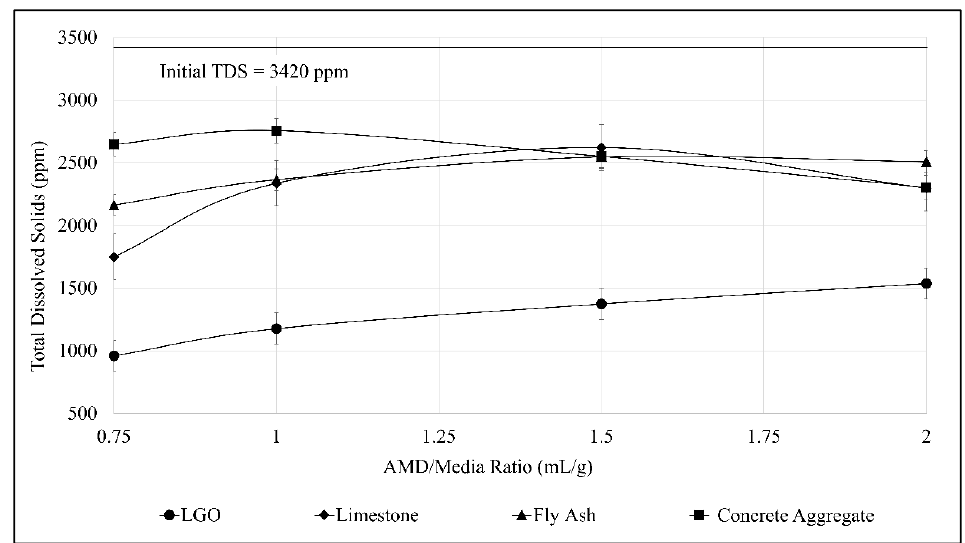
Figure 5. Effect of AMD/Media ratio on total dissolved solids (TDS) after 1-h mixing.